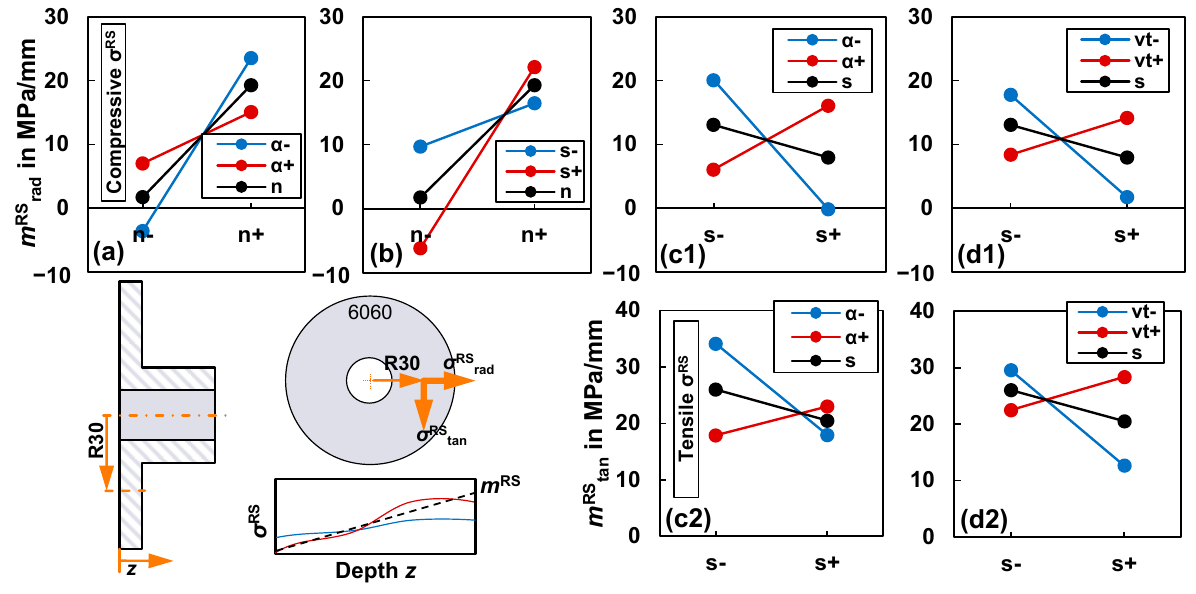
Figure 11. Effects and interactions of the process parameters, determined with the design of experiments (DoE) methods, tool angle α , rotation speed n , wall thickness s x , quenching v t on the gradient m RS of the residual stress depth profile of aluminum (6060) flanges formed by friction-spinning. Interaction of (a) rotation speed and tool angle, (b) rotation speed and wall thickness, (c1, c2) wall thickness and tool angle, (d1, d2) wall thickness and quenching.